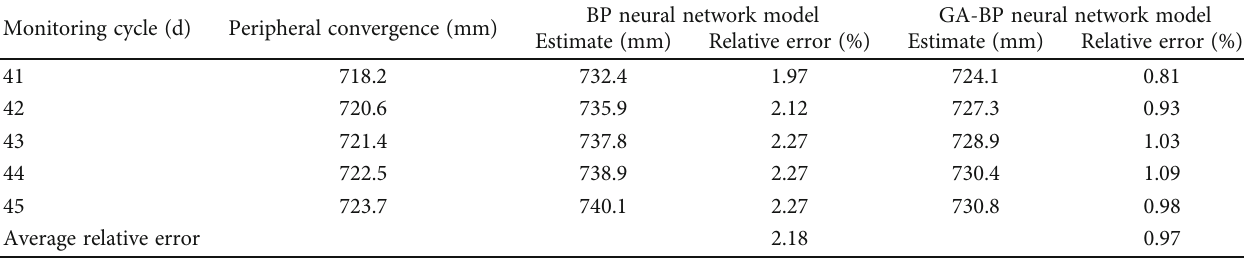
Table 4: Later prediction results.